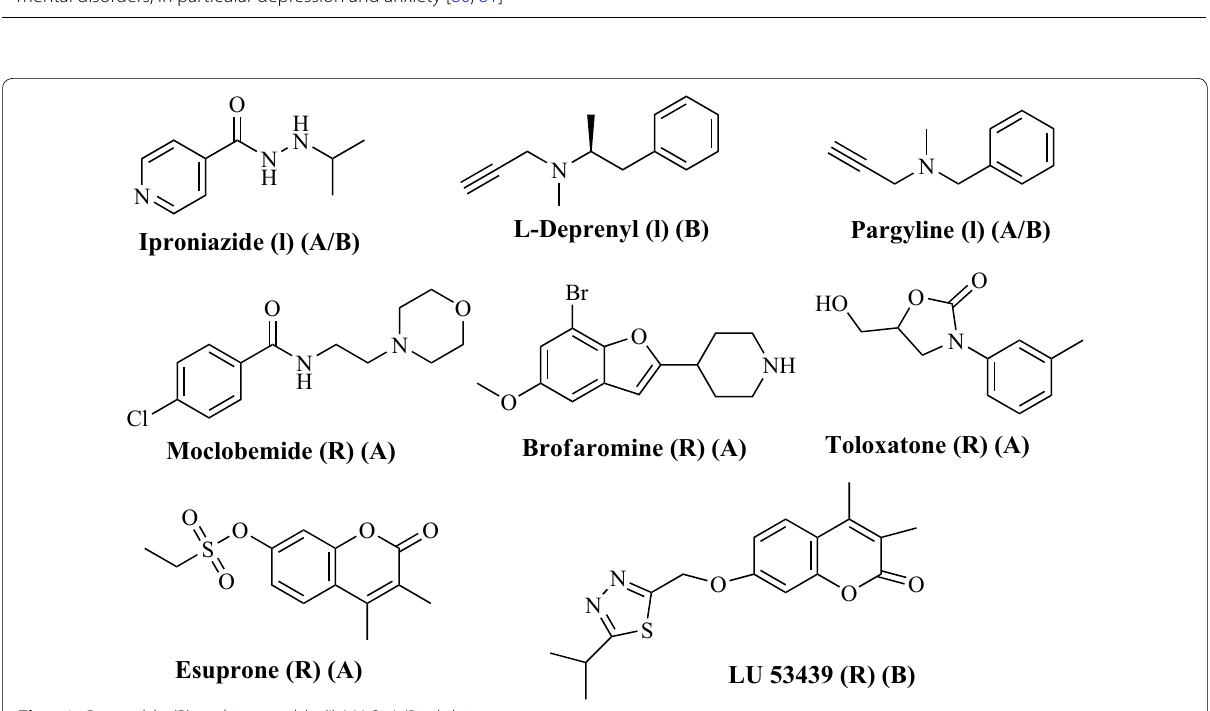
Fig. 53 Reversible (R) and irreversible (I) MAO-A/B inhibitors